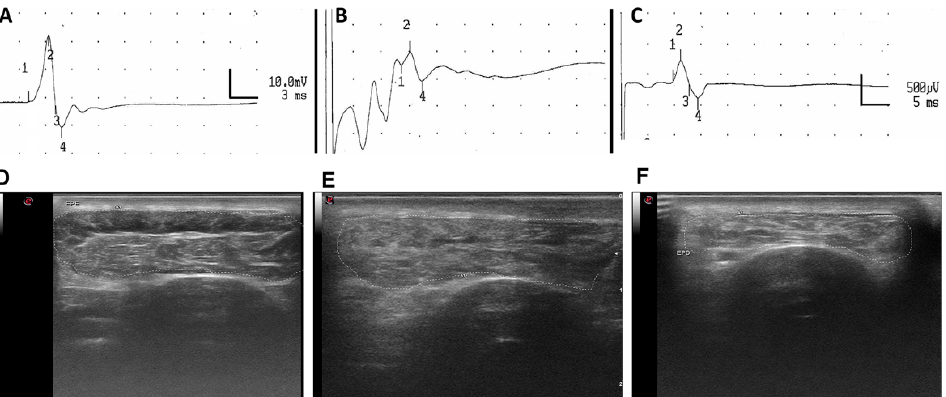
Figure 5. Representative EMG recordings of the CMAP recorded in the TA muscle evoked by stimulation of the sciatic nerve in the intact left hindlimb ( A ), and in the operated right hindlimb of a sheep at 6.5 ( B ) and 9 ( C ) months after operation. Labels: “1” at the onset, “2” at the peak, “4” at the end of the CMAP. Scale in A: amplitude 10 mV/square and time 3 ms per square; in B and C : amplitude 500 µV/square and time 5 ms per square. Representative echographic images of the TA muscle recorded in the intact left hindlimb ( D ) and in the operated right hindlimb of a sheep repaired with an autograft ( E ) or with a decellularized nerve allograft ( F ). Table 1. Values of the nerve conduction tests in the peroneal nerve and of the echography tests in the peroneal innervated muscles, in the control left limb and in the operated right limb ( n = 5 each) at 6.5 and 9 months postoperation. * p < 0.05 vs. AG; ** p < 0.01 vs. AG. Results were analyzed by unpaired t test using GraphPad Prism 8 software.